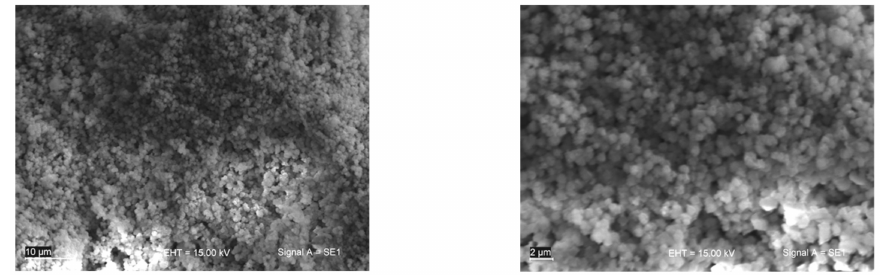
Figure 3. SEM images of CFAZ.